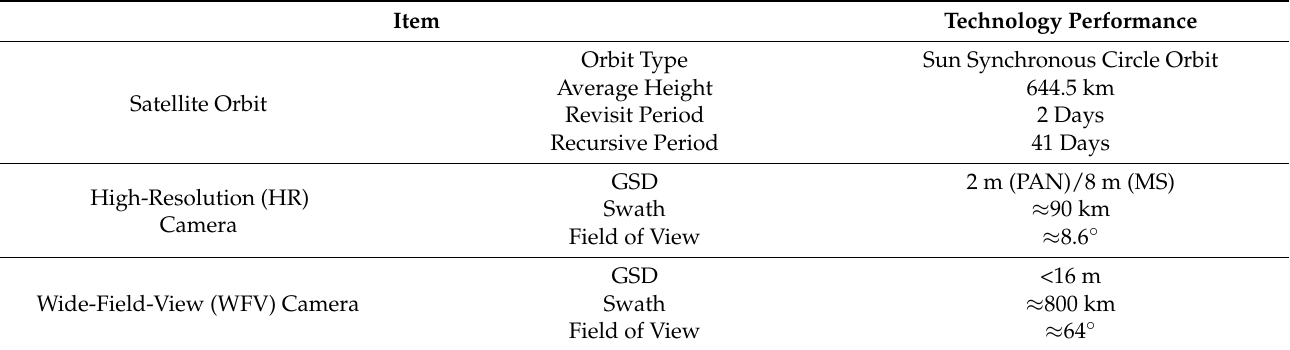
Table 2. The basic parameters of the GF-6